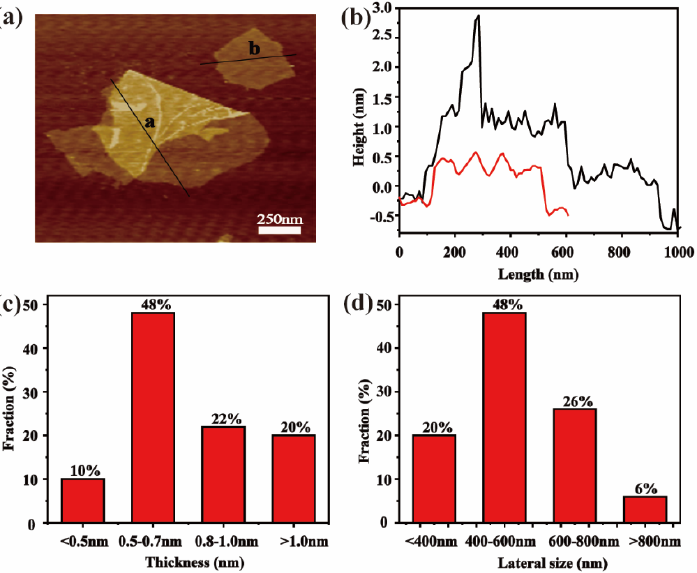
Figure 2. Characterization of exfoliated graphite compound by AFM: ( a ) AFM image and ( b ) the corresponding height profile; ( c ) statistical distribution of thickness and ( d ) lateral size distribution of exfoliated graphite compound obtained from the AFM images. The thickness and lateral size histograms were obtained from the analysis of 50 arbitrarily selected flakes.